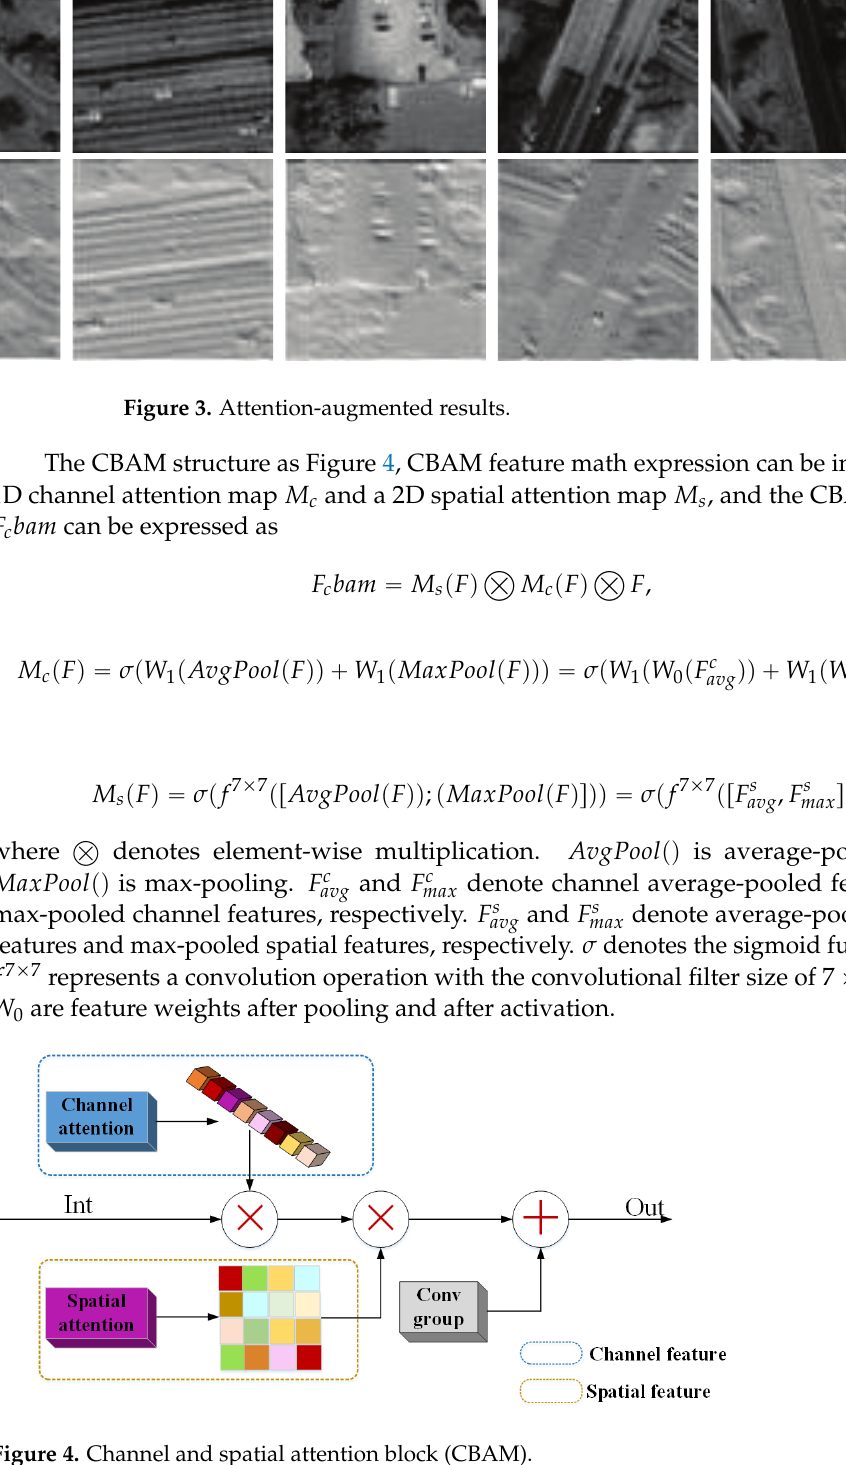
Figure 4. Channel and spatial attention block